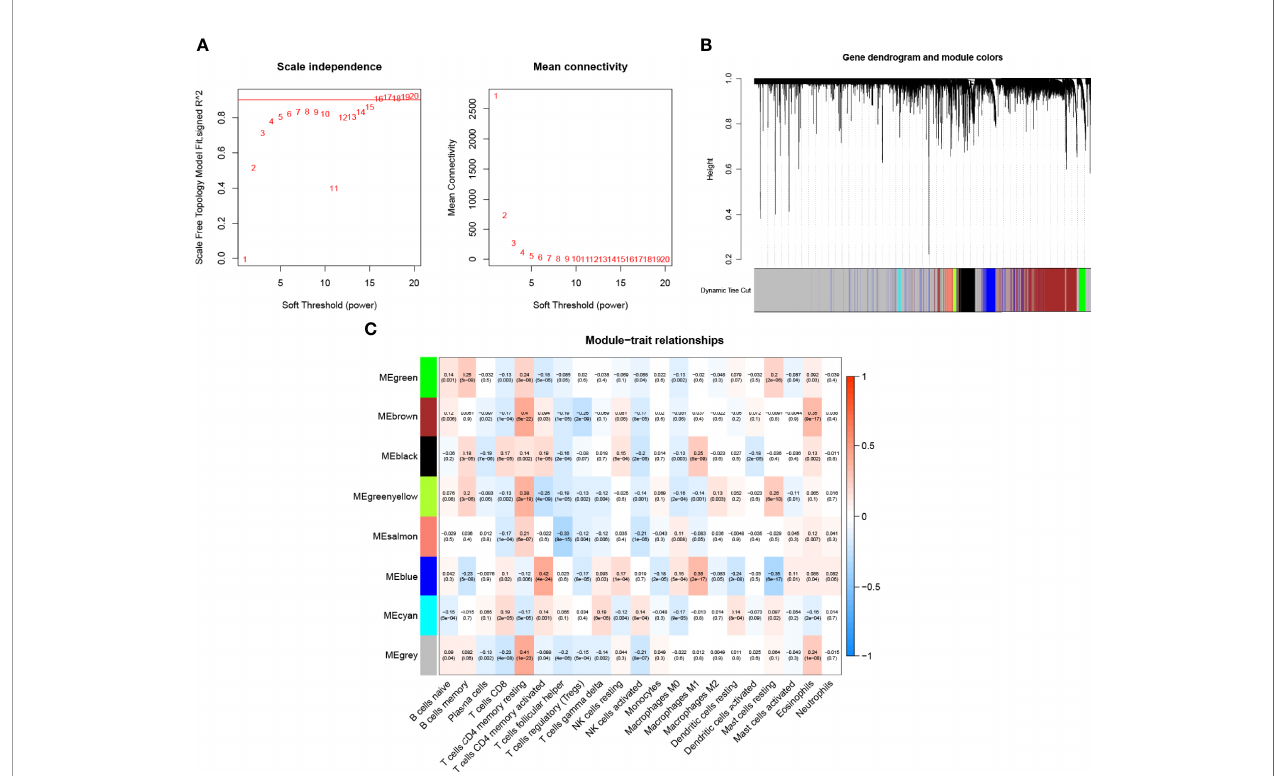
FIGURE 2 | Choosing an appropriate soft threshold (power) and building a hierarchical clustering tree. (A) The choice of the soft threshold enables the scale-free topology to achieve an exponent of 0.90, and the average connectivity for 1 – 20 soft threshold powers is analyzed. (B) M2 macrophage-related genes with similar expression patterns were merged into the same module using a dynamic tree-cutting algorithm, creating a hierarchical clustering tree. Heatmap of correlations between (C) modules and immune-in fi ltrating cells